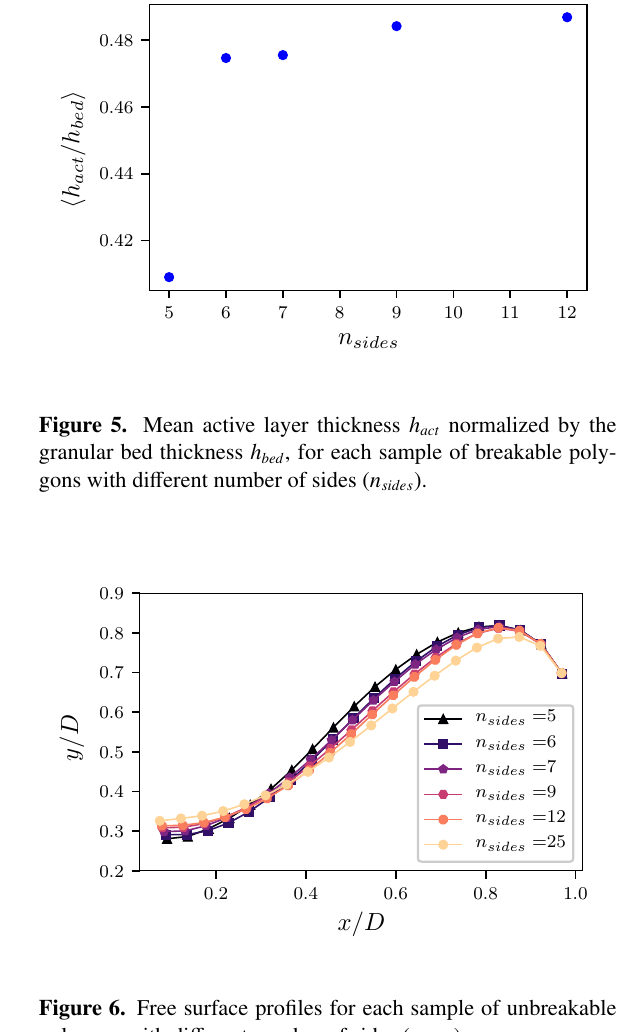
Figure 4. Velocity field (velocity projected in the stream direc- tion ~ v ) of a sample with n sides = 5.